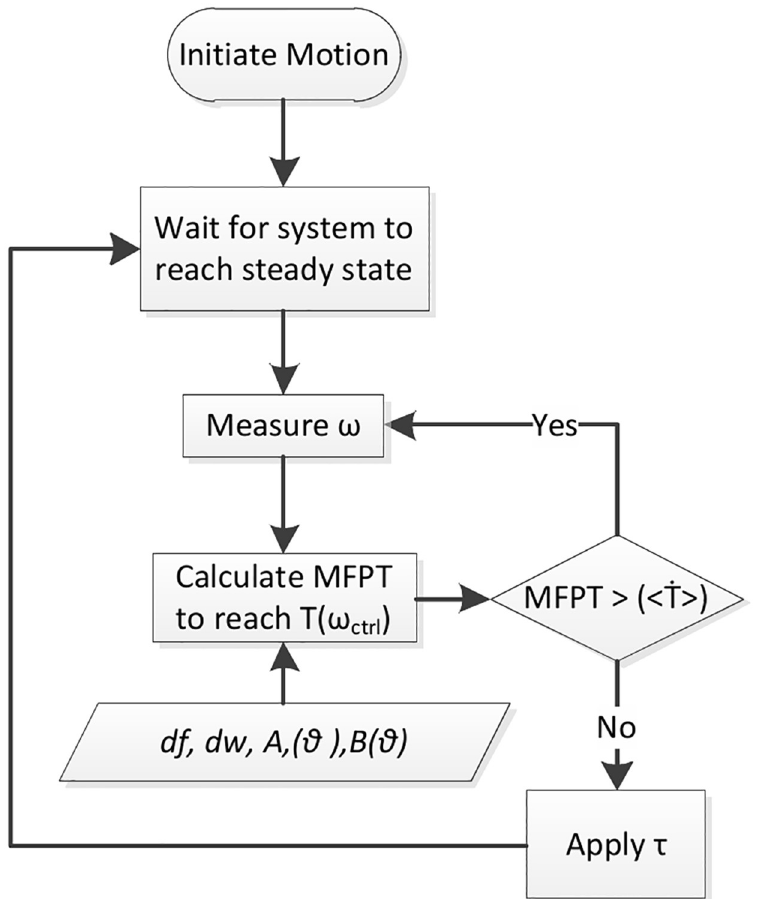
Fig 9. Flowchart of the MFPT based controller for the RW. Per step policy is used to decide if an external torque ( τ ) is applied depending on two control parameters; T ( ω ctrl ) which is the target point to which MFPT is calculated and < _ T > which is the threshold MFPT.